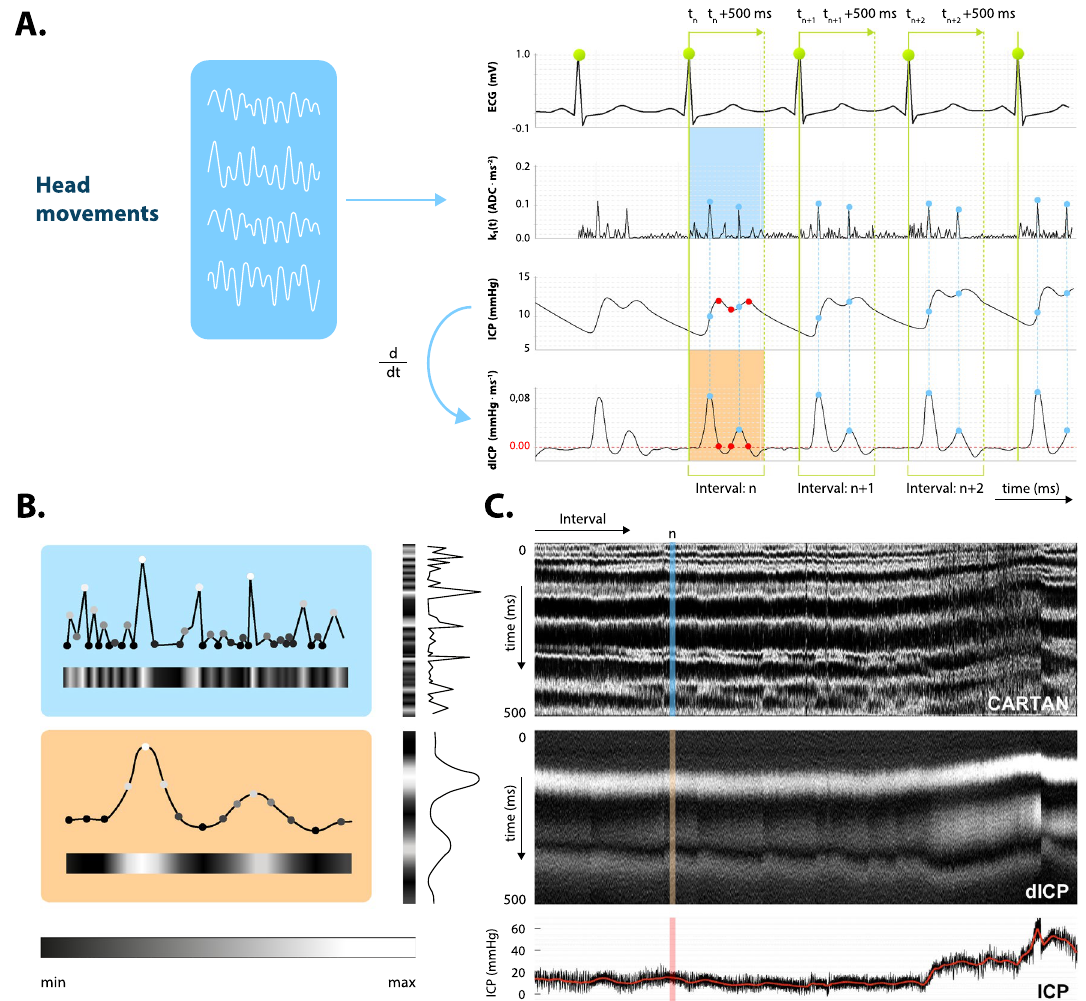
Figure 2. ( A ) The analysis starts with the pre-processing of the six synchronous signals: the four mechanical signals from the pillow-embedded sensors (ADC units), ECG (mV) and ICP (mmHg). The four-dimensional mechanical β curve is then represented by the one-dimensional k 1 (t) curvature invariant (ADC∙ms −2 ). The raw ICP signal is smoothed and time derived yielding dICP (mmHg∙ms -1 ). The k 1 (t) and dICP signals are fragmented according to the ECG R-peaks (green vertical lines) into elementary intervals (EI). From each EI only the first 500 ms are considered. ( B ) Color coding of k 1 (t) (blue box) and dICP (orange box). C . The Cartan (top) and dICP (middle) map after merging rotated strips side-by-side from left to right; the n-th EI is highlighted in blue and orange, respectively. Bottom: evolution of ICP average value (mmHg). The figure was generated using Adobe Illustrator 2020 (https:// www. adobe.